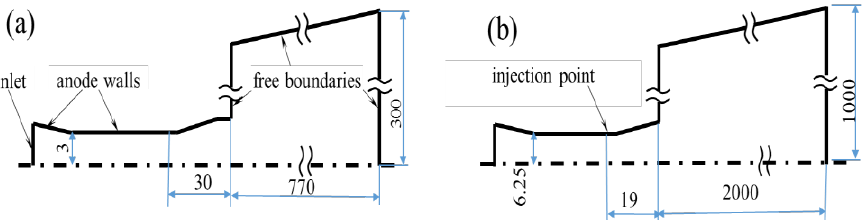
Figure 2. CFD computational domain geometry. ( a ) F4 plasma torch and ( b ) O3CP plasma torch. All dimensions are in millimeters.